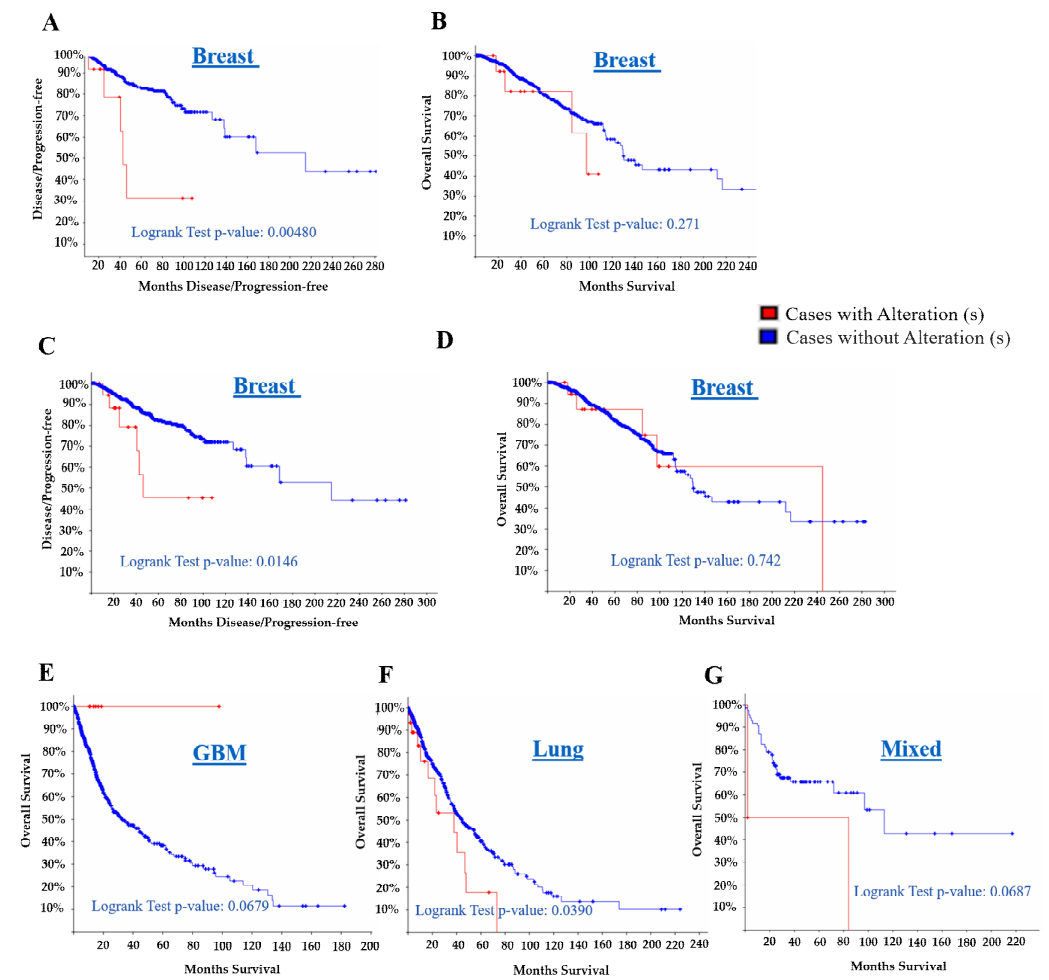
Figure 7. Kaplan-Meier Estimate for SERTAD1 alteration/mutation associated with poor prognosis and patient’s survival. ( A & B ) Breast Invasive Carcinoma (TCGA, Cell 2015) Tumor Samples with sequencing and CNA data (816 samples) (Gene Set/Pathway is altered in 15 (1.8%) of queried samples), ( C & D ) Breast Invasive Carcinoma (TCGA, Provisional) Tumor Samples with sequencing and CNA data (963 samples) (Gene Set/Pathway is altered in 23 (2.4%) of queried samples), ( E ) Merged Cohort of LGG and GBM (TCGA, Cell 2016) Tumor Samples with sequencing and CNA data (794 samples), Gene Set/Pathway is altered in 8 (1%) of queried samples, ( F ) Pan-Lung Cancer (TCGA, Nat Genet 2016) Tumor Samples with sequencing and CNA data (1144 samples), Gene Set/Pathway is altered in 47 (4.1%) of queried samples, ( G ) Mixed Tumors (PIP-Seq 2017) Sequenced Tumors (103 samples), altered in 3 (2.9%) of queried samples.